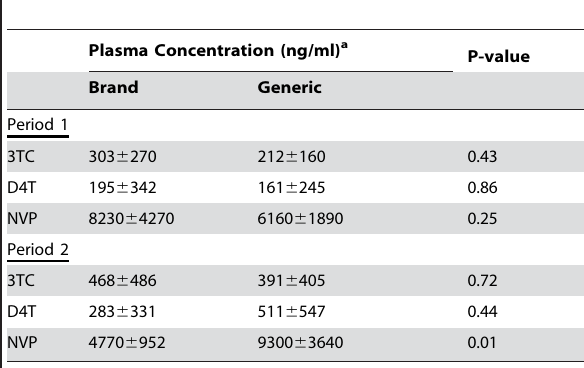
Table 2. Trough plasma concentrations prior to initiation of pharmacokinetic study.